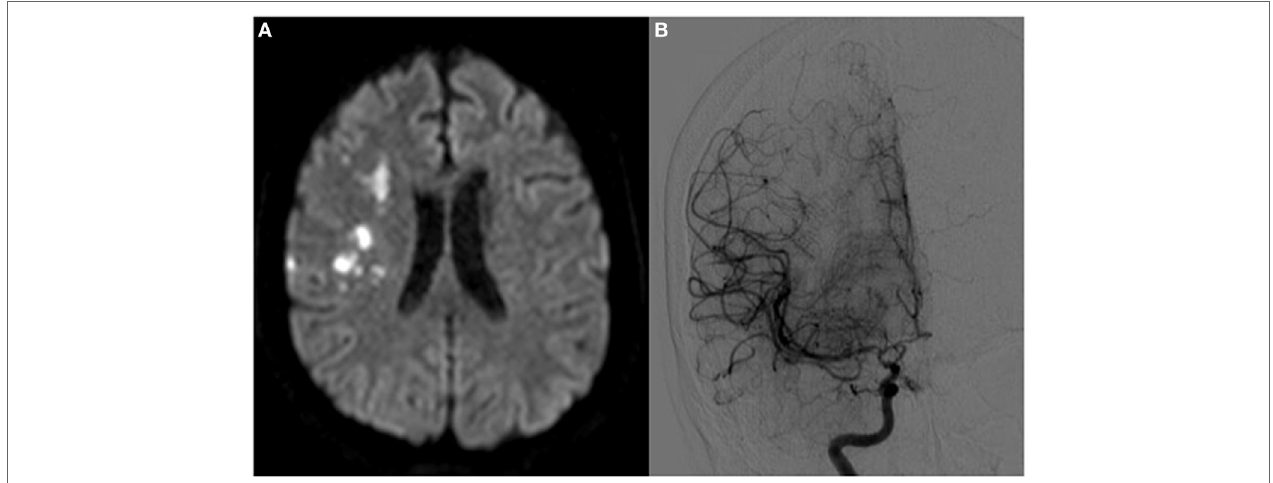
FiGURe 1 | Patient A, a 44-year-old woman with bilateral moyamoya disease, symptomatic on the right side. In panel (a) , magnetic resonance imaging demonstrates multiple embolic-appearing ischemic infarcts in the right middle cerebral artery territory. Panel (B) demonstrates cerebral angiogram with severe right ICA stenosis with